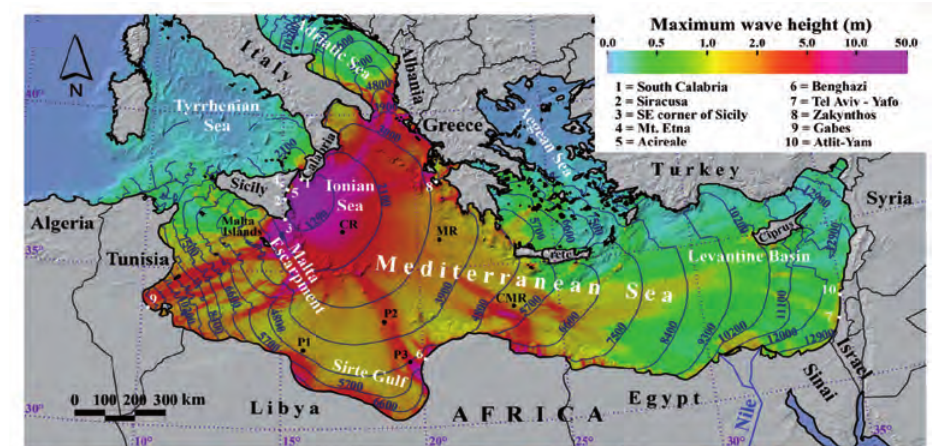
Figure 9. Maximum wave crests heights predicted by a scenario of a tsunami generated by the flank collapse of Mt. Etna in the eastern Mediterranean (after Pareschi et al., 2006b). Blue lines are arrival times, in seconds, of the first tsunami maximum.